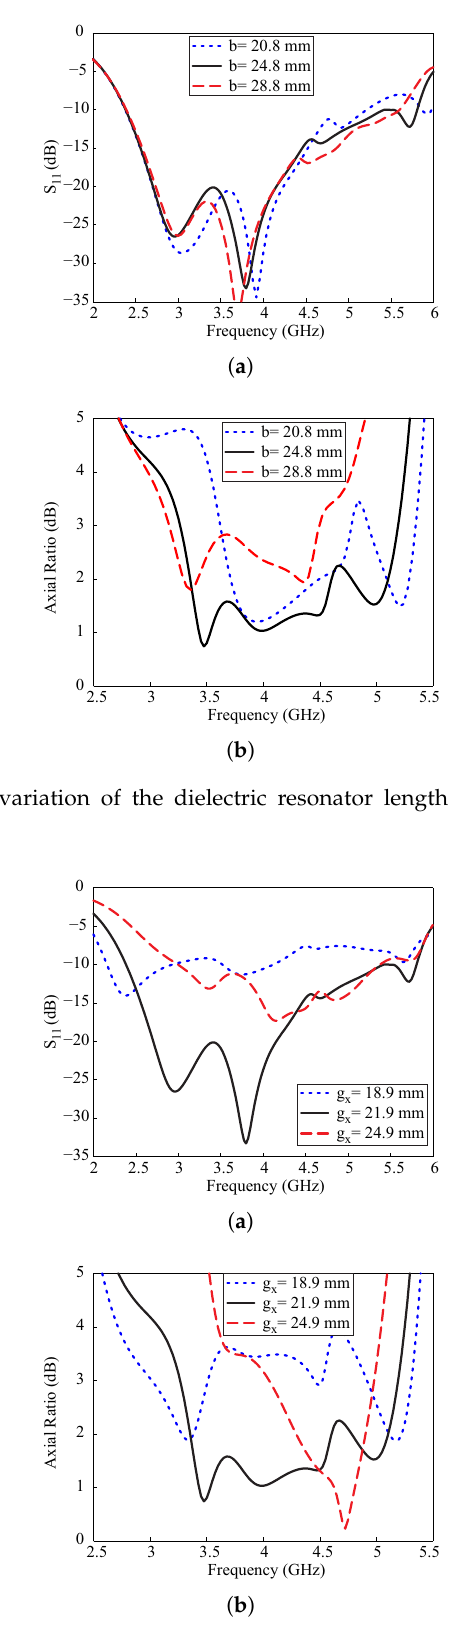
: ( a ) reflection coefficient; ( b ) axial x